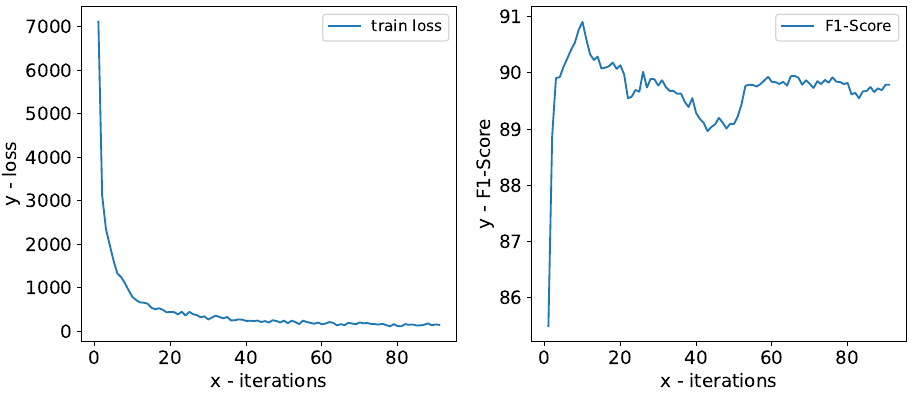
Figure 12. spaCy model learning curve.